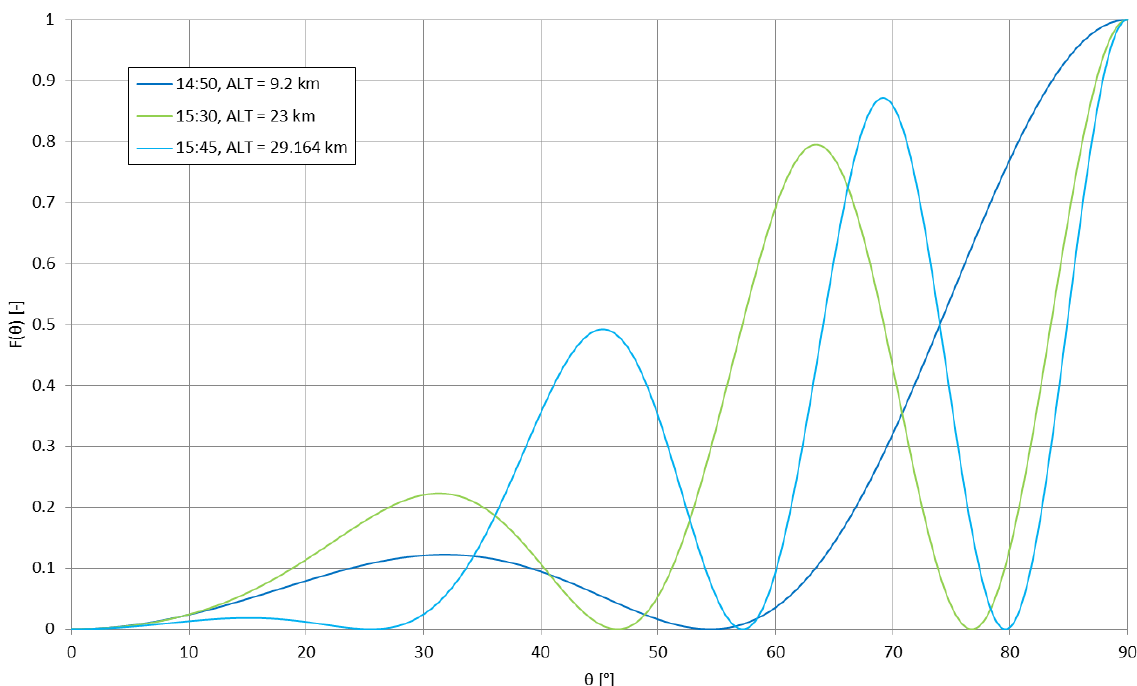
Figure 13. The antenna’s power patterns for maximum signal strengths and their corresponding altitudes, as seen on the spectrum in Figure 9.